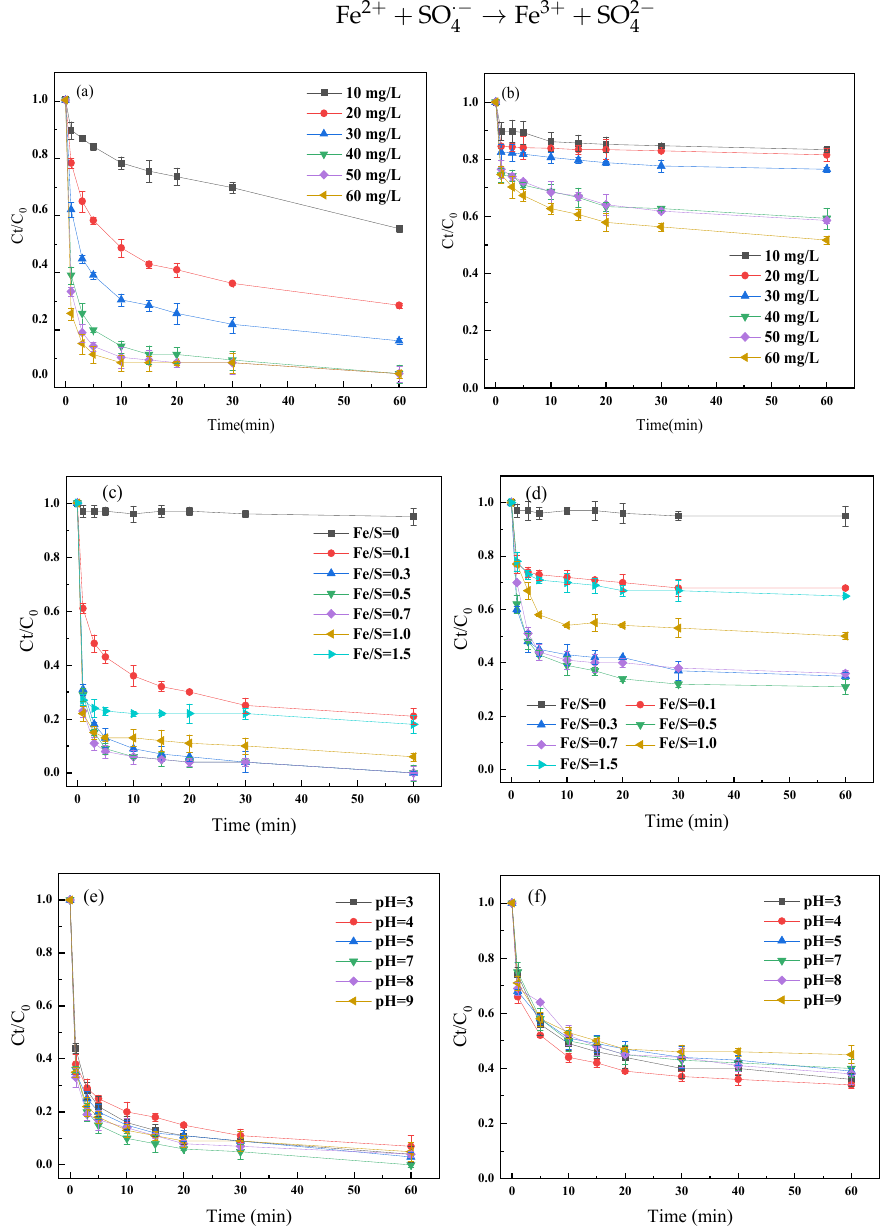
Figure 2. The degradation efficiency of RBR X-3B under different PS concentrations: ( a ) SO 42 − free and ( b ) with SO 42 − ; Fe 2+ /PS ratios: ( c ) SO 42 − free and ( d ) with SO 42 − , and initial pH: ( e ) SO 42 − free and ( f ) with SO 42 − . [Na 2 SO 4 ] 0 = 3 g/L, PS = 40 mg/L, Fe 2+ /PS = 0.3, pH = 7, and [X-3B] 0 = 50 mg/L.